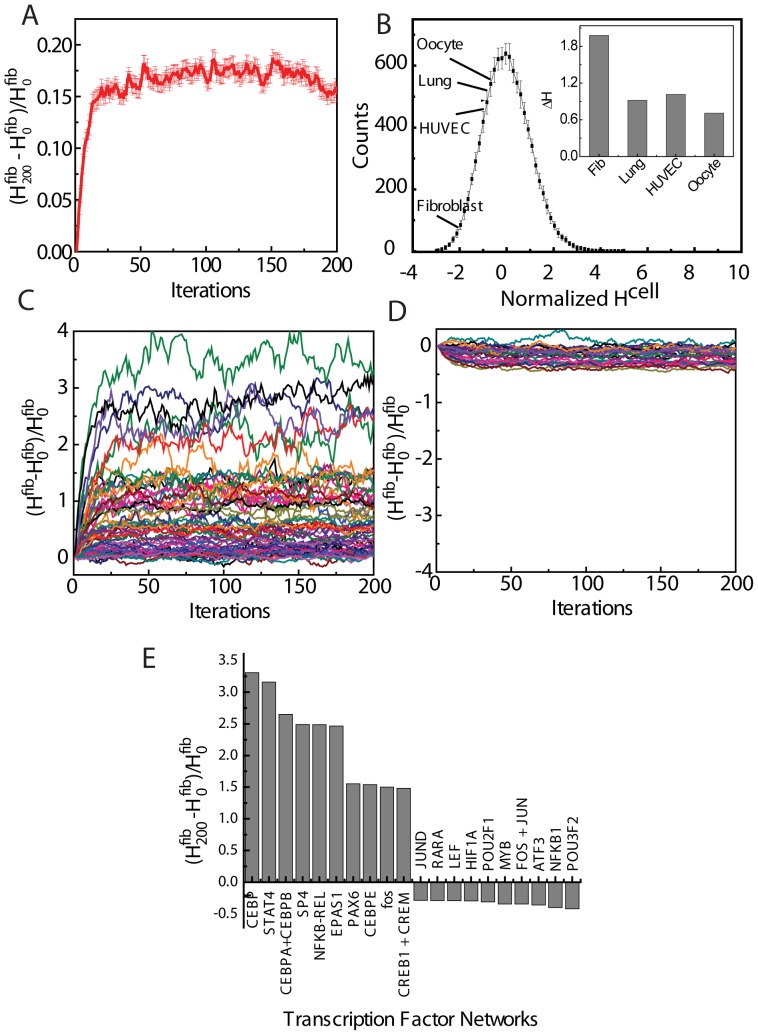
Computation of function H to measure the correlation between physical organization (IPD) and network activity (Φ).(A) Evolution of H value when the adjacency matrix Afib
ij is randomized. (B) The normalized histogram represents the distribution of the H-Values for all four cell types. Inset shows deviations ΔH
cell of H
cell
0 from average random H
cell
av measured in units of standard deviation σ (C, D) Differential changes in the evolution of H value for individual TFNs (c-increase, d-decrease). (E) Selected TFNs which show large increase and decrease in H-value. Error bars indicate S.E.M over 20 simulations.